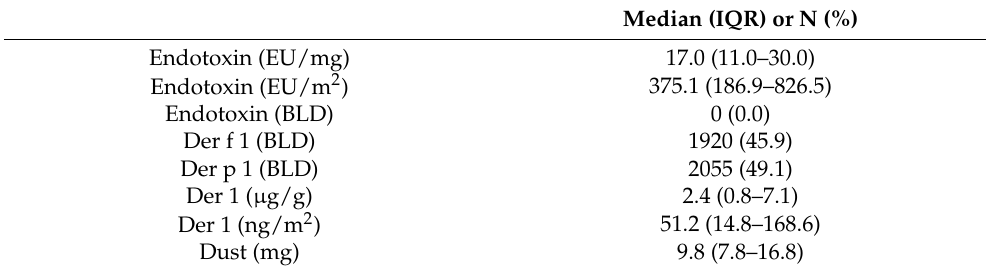
Table 2. Endotoxin and Der 1 levels in dust samples.